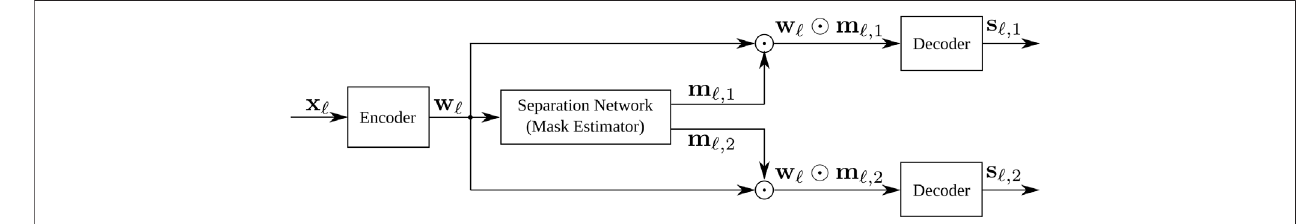
FIGURE 1 | Generalised TasNet Model Schematic (exemplary shown for two speakers, C